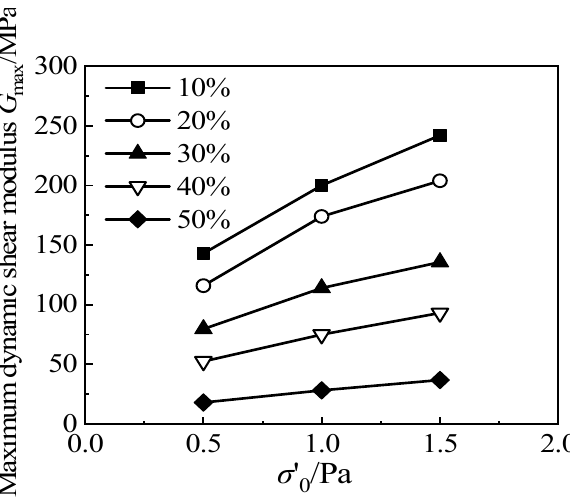
Figure 19. The relationship between G max and σ′ 0/ Pa with different rubber content. Figure 20 shows the variation of the maximum dynamic shear modulus, G max , of the RCS soil, with the cement content under different confining pressures when the rubber content is 20%. It can be seen that the maximum dynamic shear modulus, G max , of RCS soil increases with the increase in cement content.